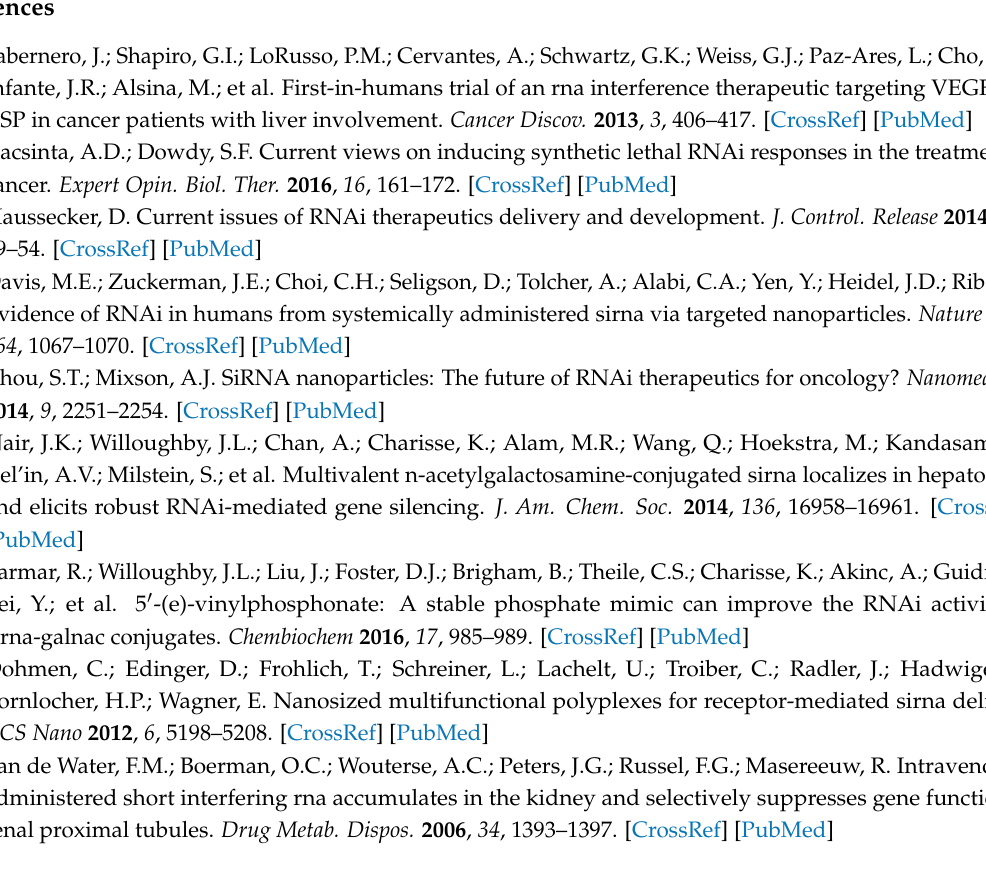
Figure S1: Synthesis of heterotelechelic DBCO-pSar polyplex shielding agents by NCA polymerization and subsequent amidation for further introduction of functionalities, Figure S2: siRNA binding ability of T-shape structures analyzed with an agarose gel shift assay, Figure S3: Cellular internalization of siRNA formulations shielded with increasing equivalents of DBCO-pSar 119 determined by flow cytometry, Figure S4: Electrophoretic mobility of formulations, Figure S5: Biodistribution of siRNA formulations in NMRI-nude mice bearing Neuro2A tumors after i.v. administration, Figure S6: Cellular binding, cellular internalization and transfection efficiency of folate targeted siRNA polyplexes and untargeted analogues, Table S1: Analytical data of synthesized heterotelechelic DBCO-pSar ligands, Table S2: Particle size and zeta potential of siRNA formulations determined with a DLS